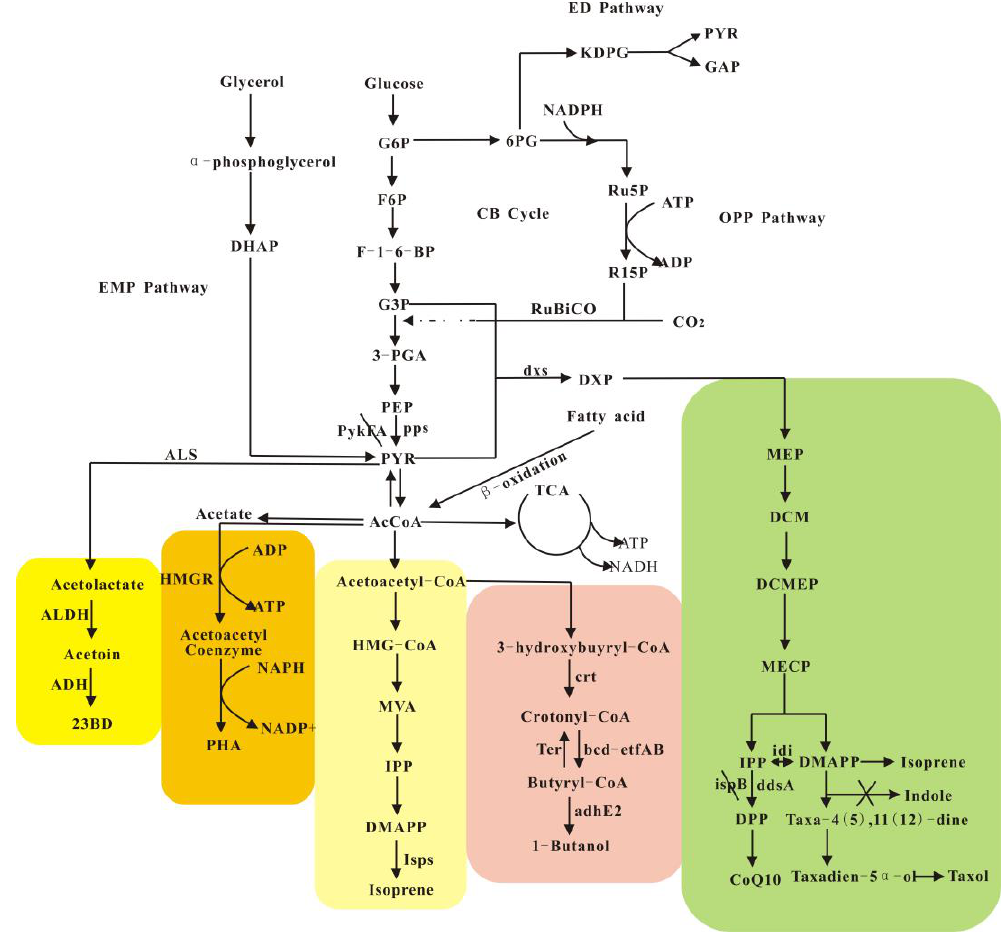
Figure 1. Highly complex metabolic pathways for the biosynthesis of representative bio-based products (with difference colors) from variable substrates like glucose, glycerol, fatty acids and CO 2 .